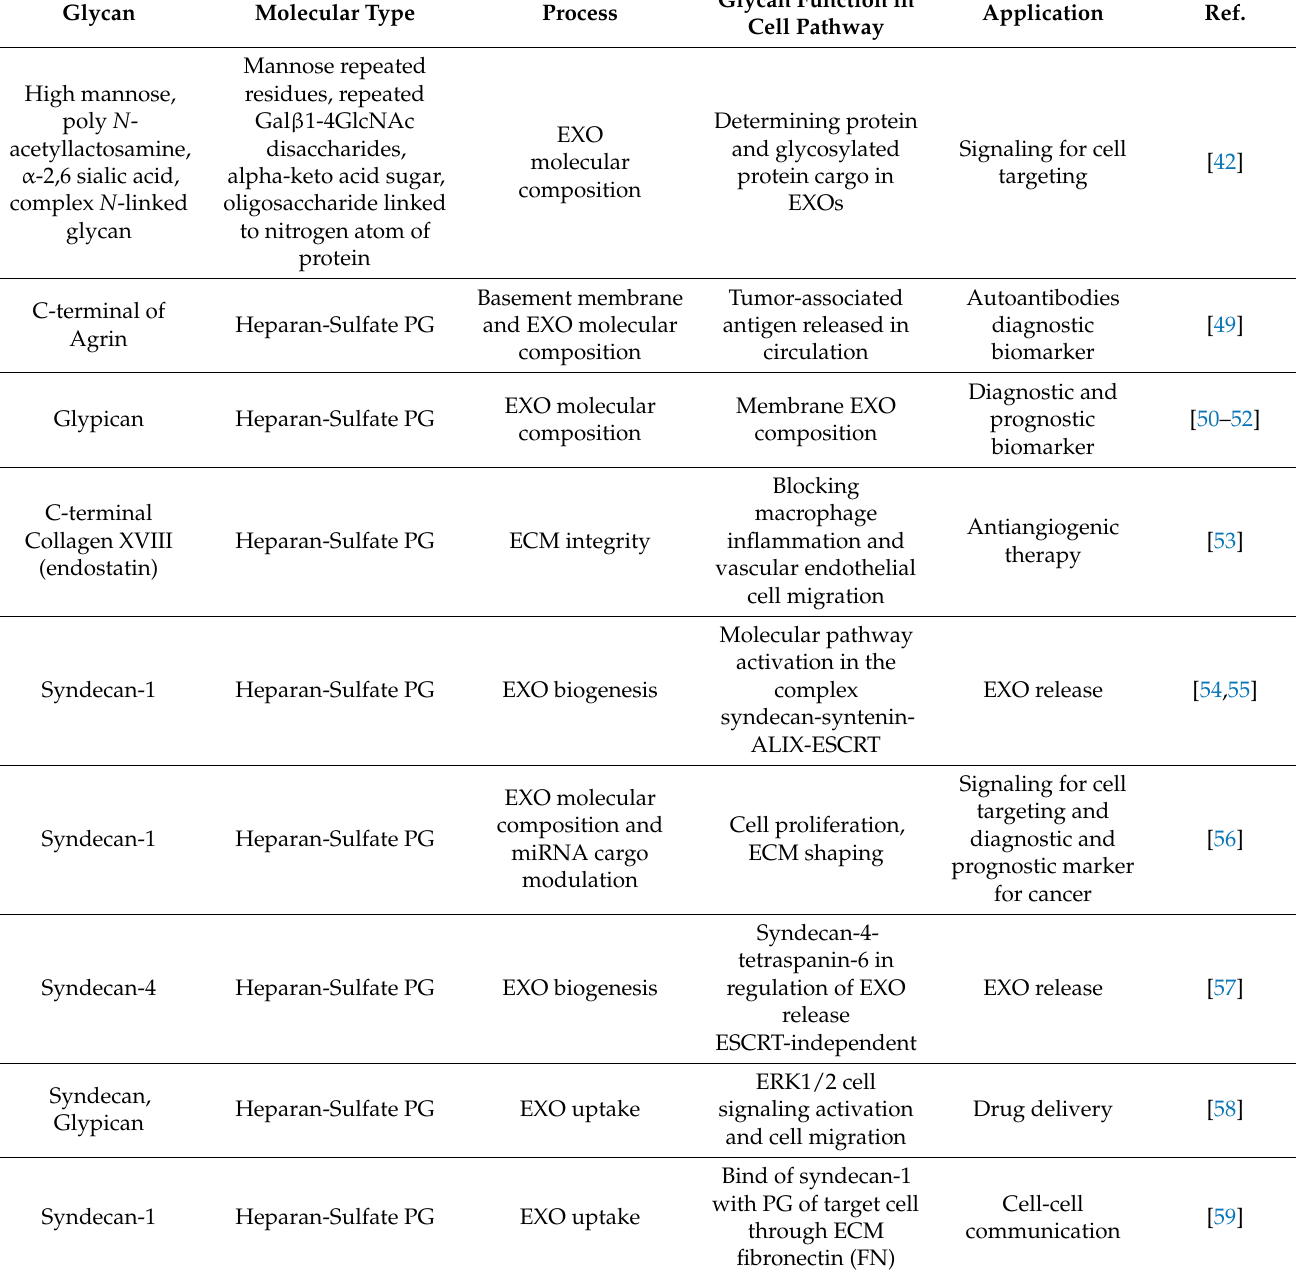
Table 1. Glycans in EXO biogenesis, layout and cell